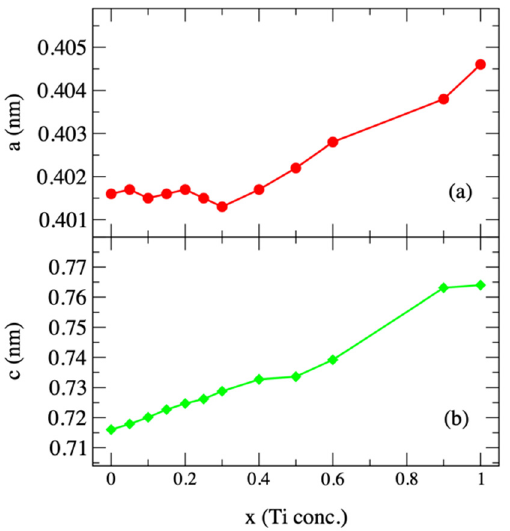
Figure 2. Changes in the parameters of the crystal structure a ( a ) and c ( b ) in GdMn 1- x Ti x Si depending on x (the Ti concentration), according to the data of [19] for the CeFeSi -type phase.